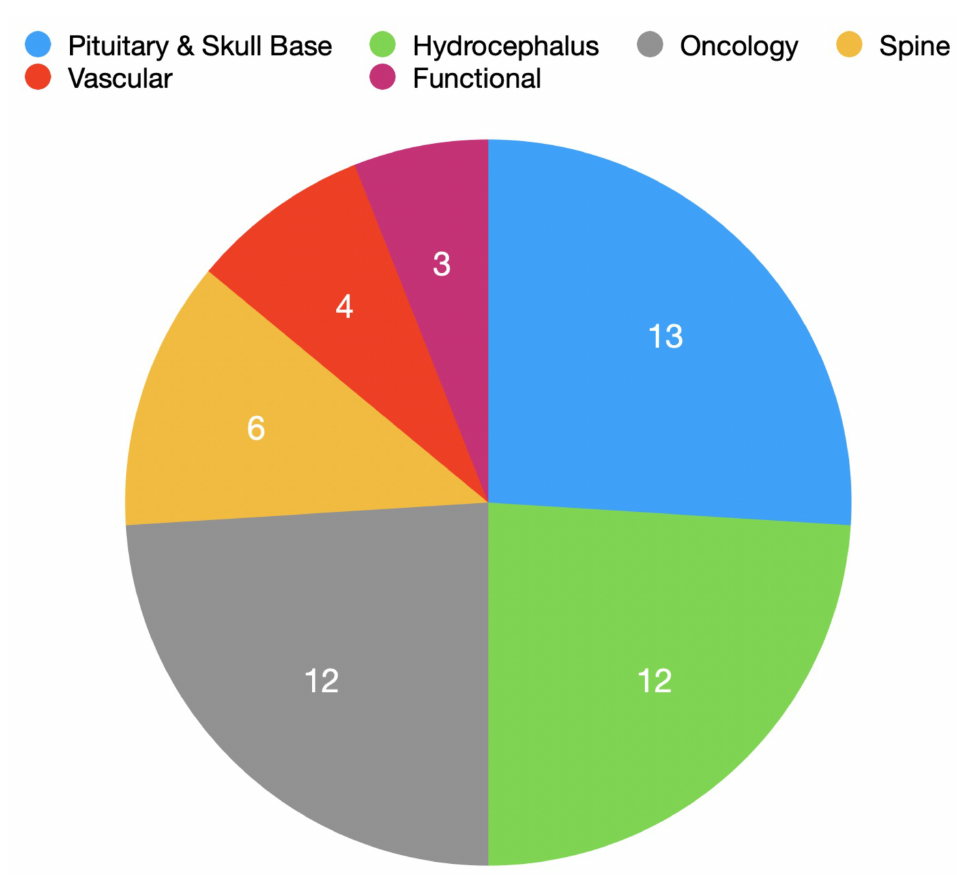
Figure 3. Number of novel instruments identified by neurosurgical